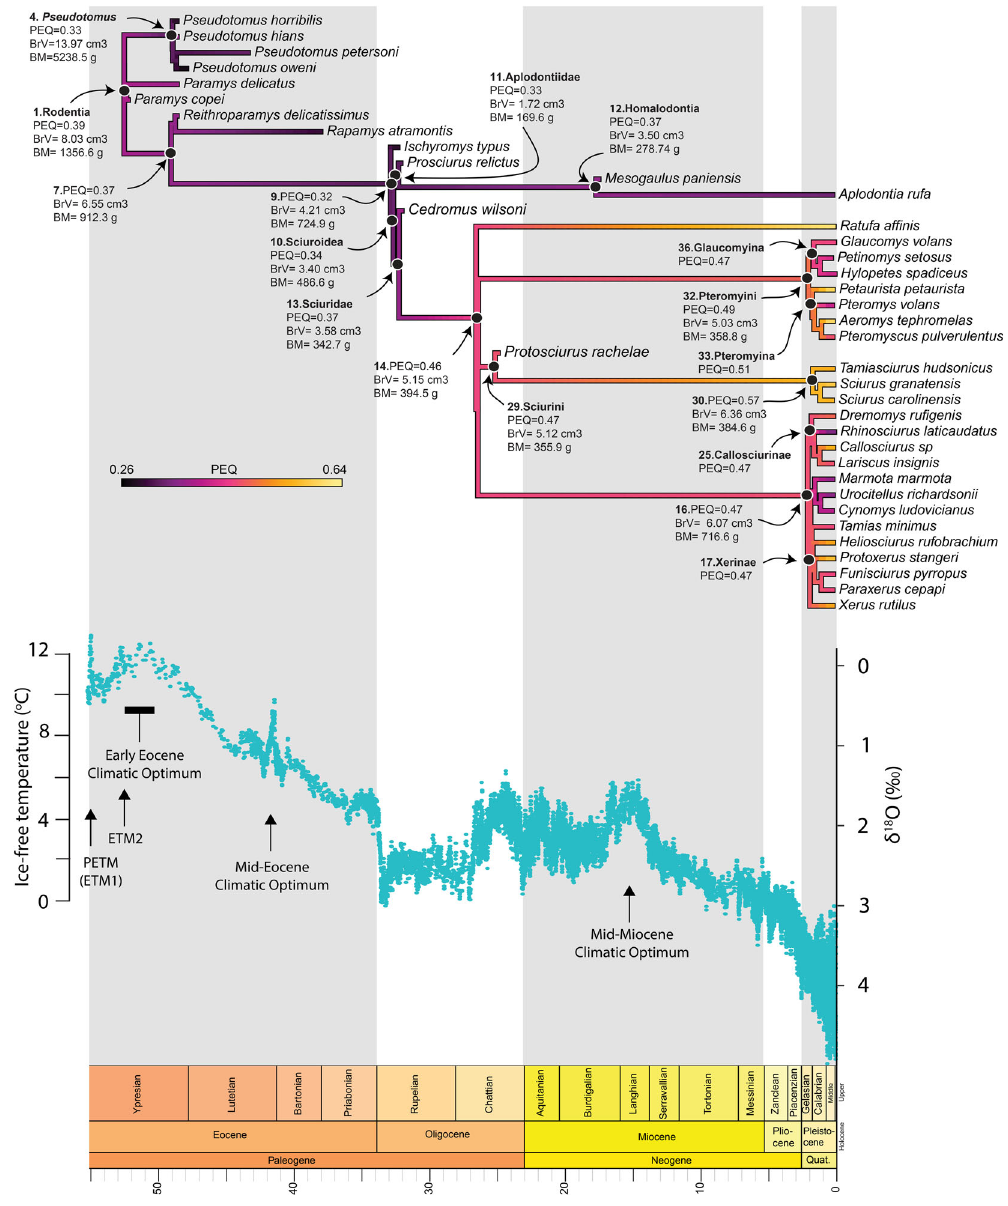
Fig. 4 Ancestral state reconstruction of the Phylogenetic Encephalization Quotient (PEQ) with a geological time scale. The temperature and oxygen level ( δ 18 O) plot during the Cenozoic is modi fi ed from Zachos et al. 40